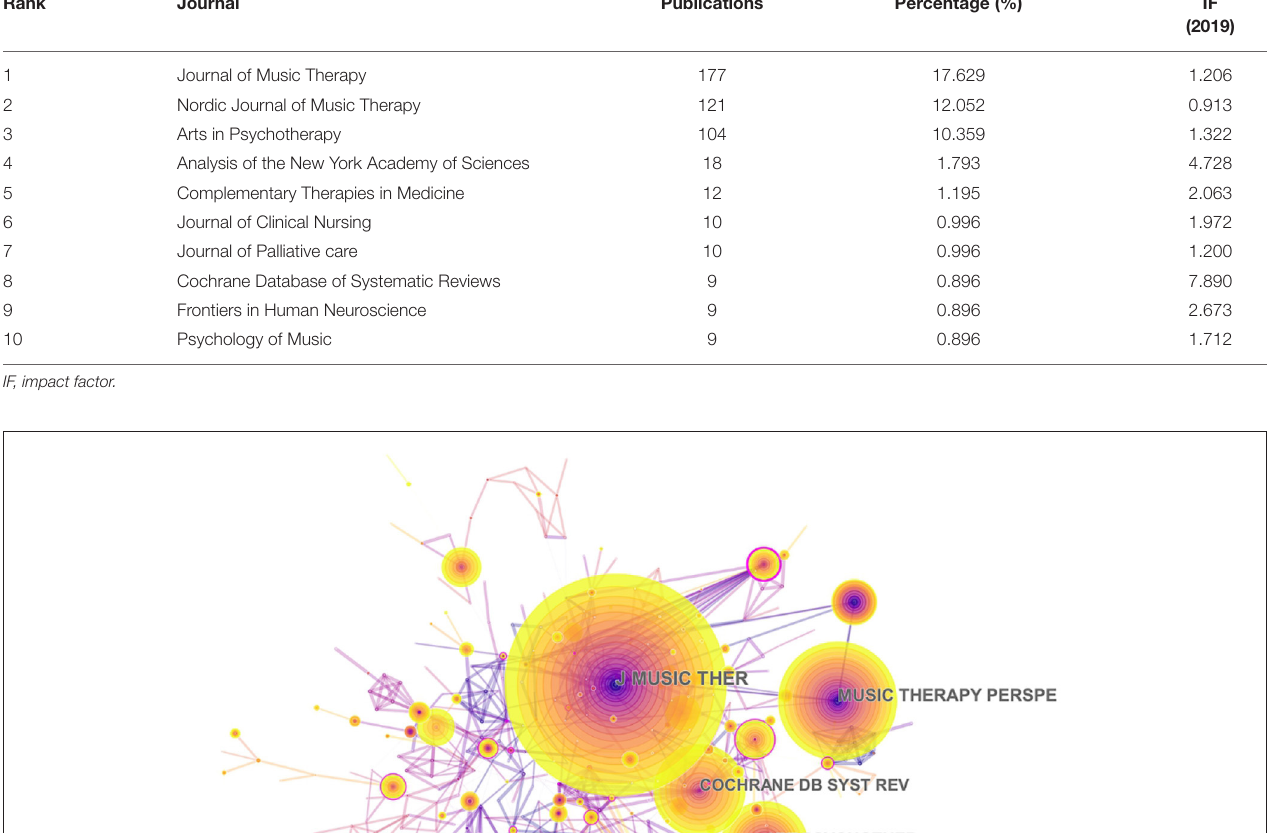
“depression.” The keyword “autism” has the highest